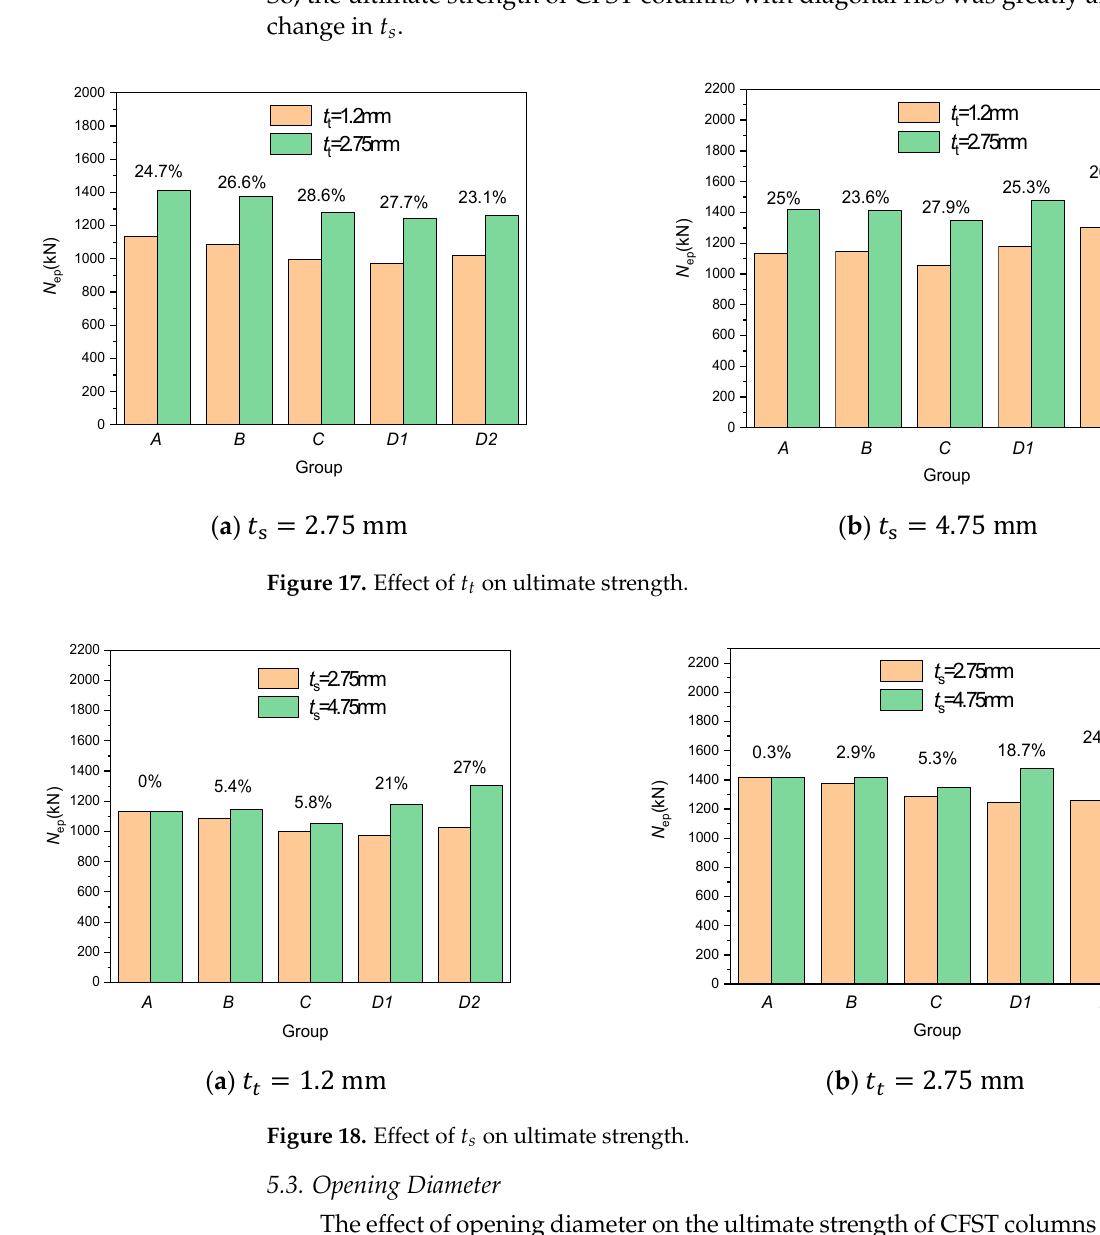
Figure 18. Effect of 𝑡 (cid:3046) on ultimate strength.